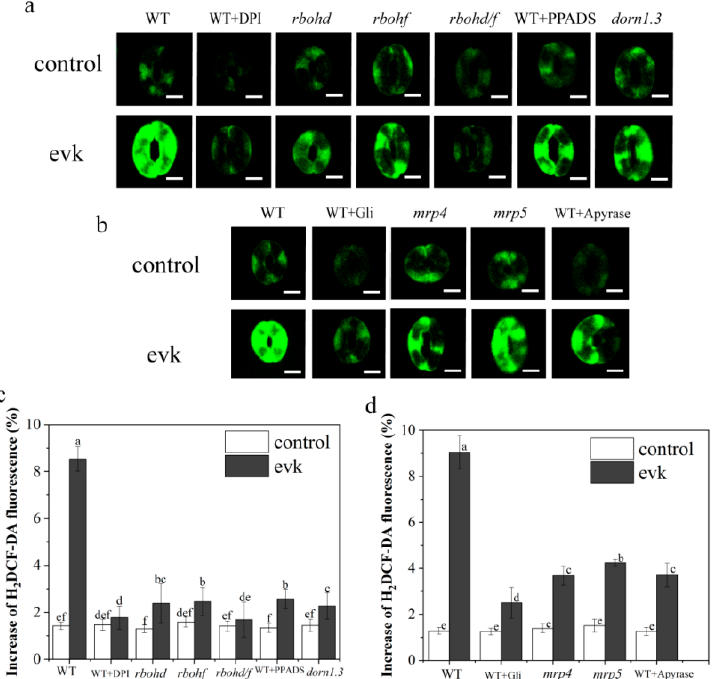
Figure 4. Evk-induced H 2 O 2 generation in guard cells is NADPH-dependent and eATP may work upstream of H 2 O 2 burst. ( a ) Evk-induced H 2 O 2 generation in WT, WT pre-treated with DPI, mutant dorn1.3 , rbohd , rbohf , and rbohd/f guard cells. The vertical scale represents the relative increase in H 2 DCF-dependent fluorescence. The H 2 DCF-dependent fluorescence of guard cells before 8 μ M evk treatment was normalized to the control value. Data were obtained from at least 60 guard cells and bars represent standard error of the mean. ( b ) Photographs were taken from representative epidermal strips loaded with H 2 DCF-DA in Gli-pretreated WT, Apyrase-pretreated WT, WT, mrp4, and mrp5 lines, respectively. ( c ) Evk-induced increases in H 2 O 2 fluorescence were significantly suppressed in DPI-treated WT, mutant rbohd , rbohf , rbohd/f, dorn1.3, and PPADS-treated WT cells compared to evk-treated WT control cells. ( d ) Evk-induced increases in H 2 O 2 fluorescence were significantly suppressed in Apyrase-treated WT, Gli-treated WT, mrp4, and mrp5 cells compared to evk-treated WT control cells. Error bars denote ± SEM, n ≥ 30, and means labeled with different letters are significantly different at p < 0.05, Dunnett’s C (variance not neat).